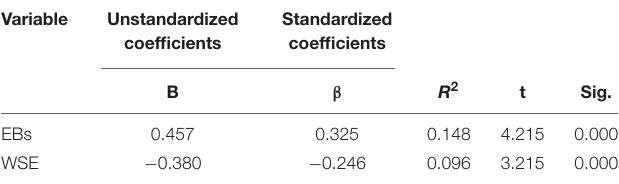
TABLE 13 | Direct maximum likelihood estimation for L2WA. Variable